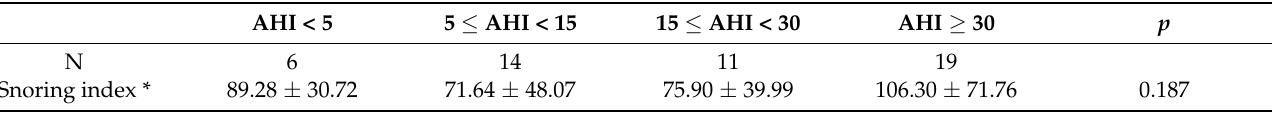
Figure 2. Block diagram of audio data handling and analysis. Table 2. Distribution of snoring index by the apnea–hypopnea index Table 1. Demographic characteristics of participants.